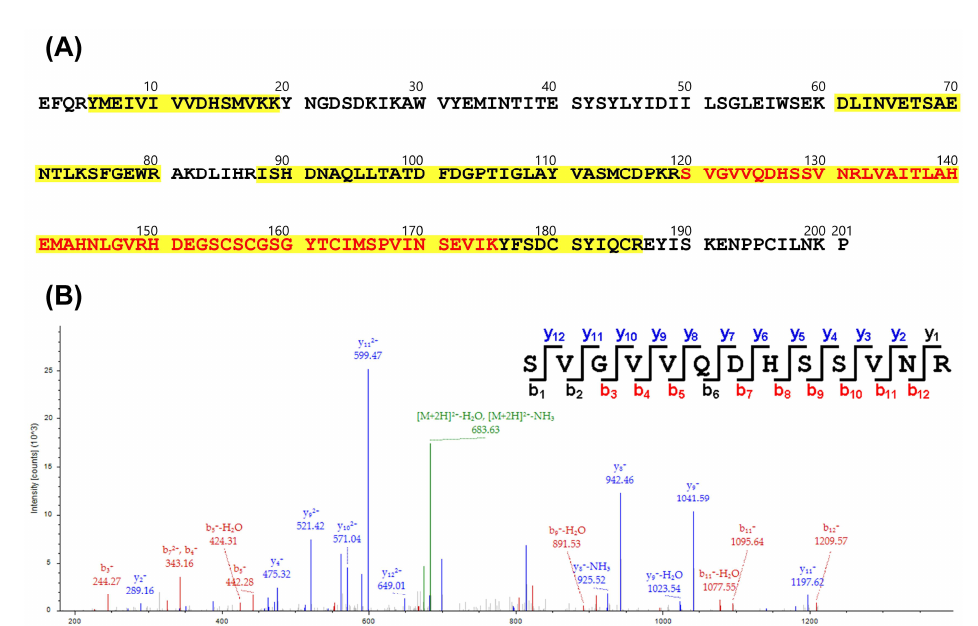
9 of 14 Figure 4. Western blot analysis of high-potency and low-potency horse plasma against HPLC-frac- tionated venom from hundred-pace pit vipers. HPLC-separated venom proteins were transferred to the PVDF membrane following SDS-PAGE and were probed with ( A ) high-potency and ( B ) low- potency plasma. The significant difference between the immunoprofiles of the two plasma samples is highlighted with a red box. To characterize the 20 kDa protein of fraction 14, LC-MS/MS was performed. The target protein band was separated via SDS-PAGE (Figure 2B), prepared using in-gel di-